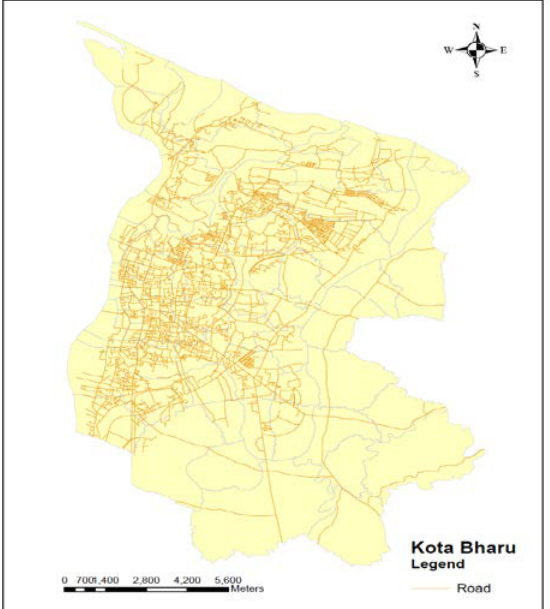
Figure 2. Digital road network within the study location